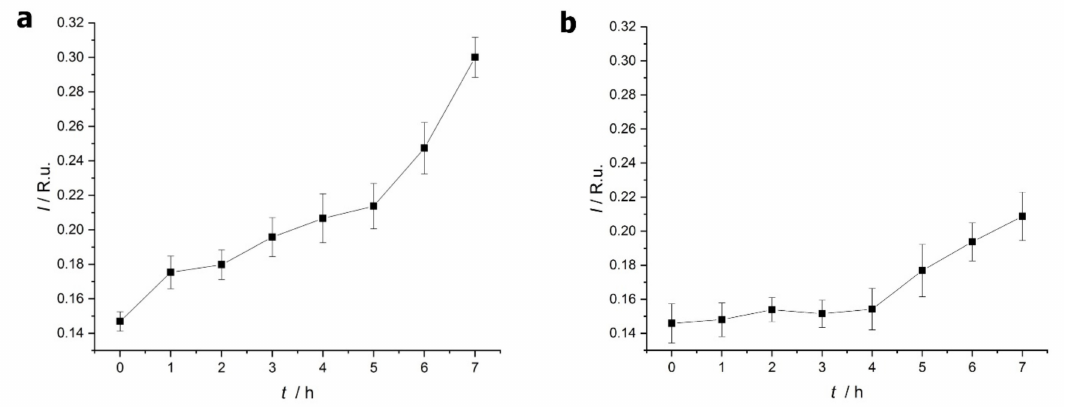
Figure 4. Fluorescence intensity (in water Raman units) of thioflavin T (ThT) with lysozyme ( a ) and β -lactoglobulin ( b ) samples as a function of thermal treatment time. The error bars represent the 95% confidence intervals. (Line is just to lead the